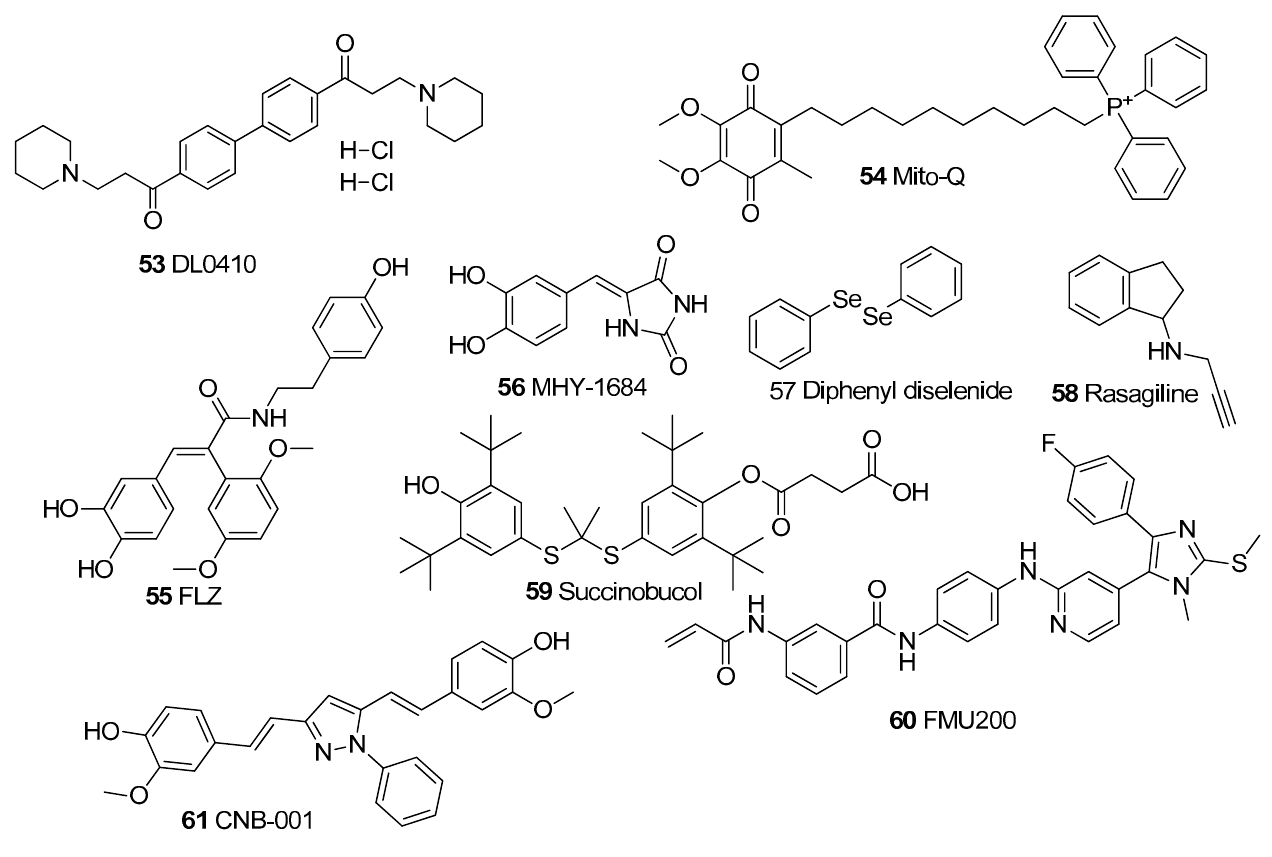
Figure 8. Chemical Structures of synthetic mitochondrial modulators.